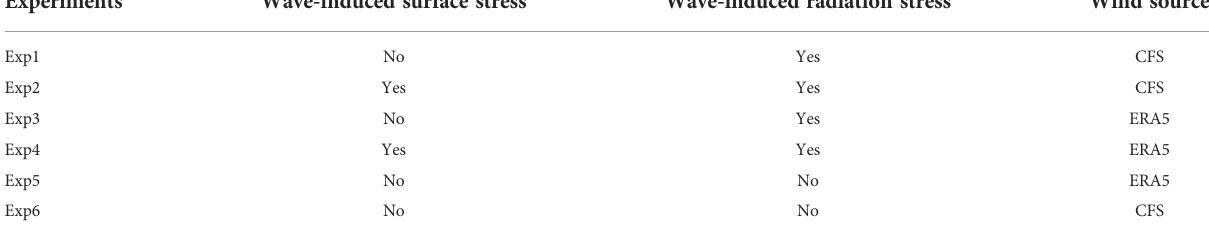
TABLE 1 Design of simulation